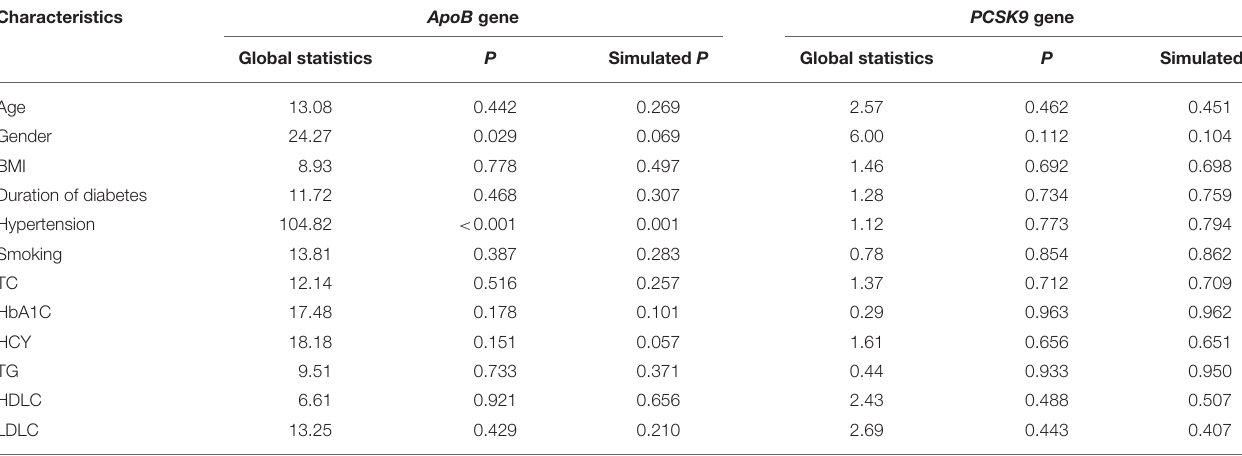
TABLE 5 | Association of all derived haplotypes as a whole in each gene with baseline characteristics of study subjects.